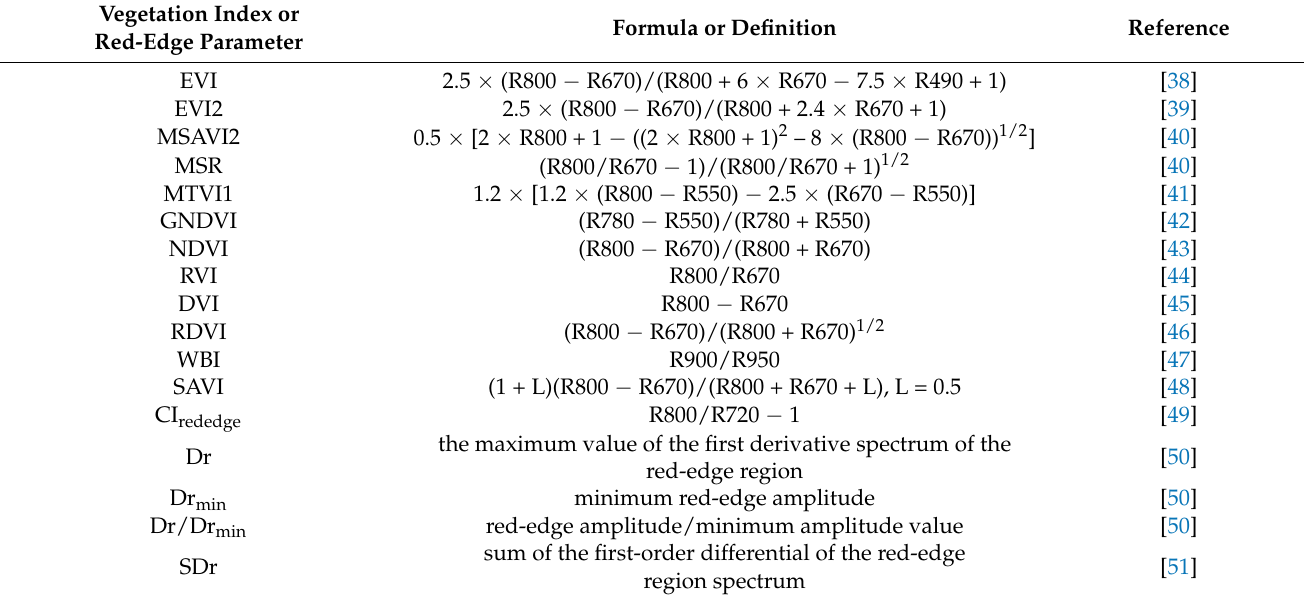
Table 2. Vegetation indices (VIs) and red-edge parameters used in this